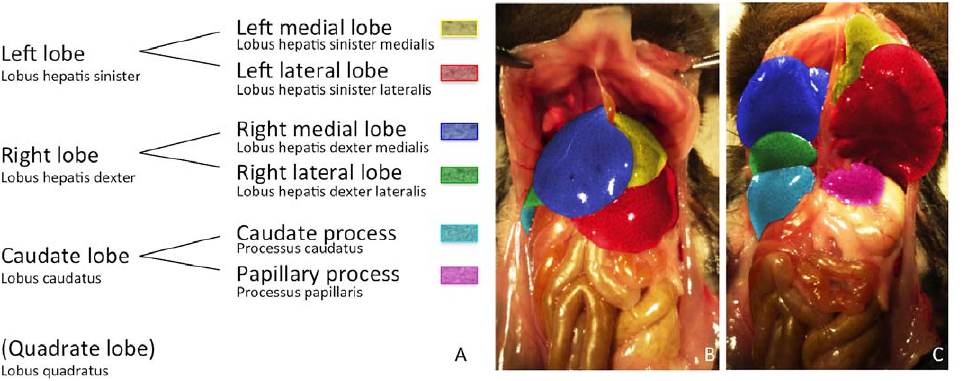
Figure 1. Illustrating the segmentation of the murine liver lobes according to the NominaAnatomicaVeterinaria. A Since in most animals we have not been able to identify the quadrate lobe in micro-CT imaging or in situ, the quadrate lobe was put in brackets and not color-coded. B and C are photographs of the liver of a C57BL/6J mouse (ventral view). In C the left and the right liver lobe have been folded cranially to reveal the liver lobes lying below. The single liver lobes have been consistently color-coded according to the schematic segmentation ( 1A ) and to the related micro- CT figures 2, 3, 4 to simplify orientation.